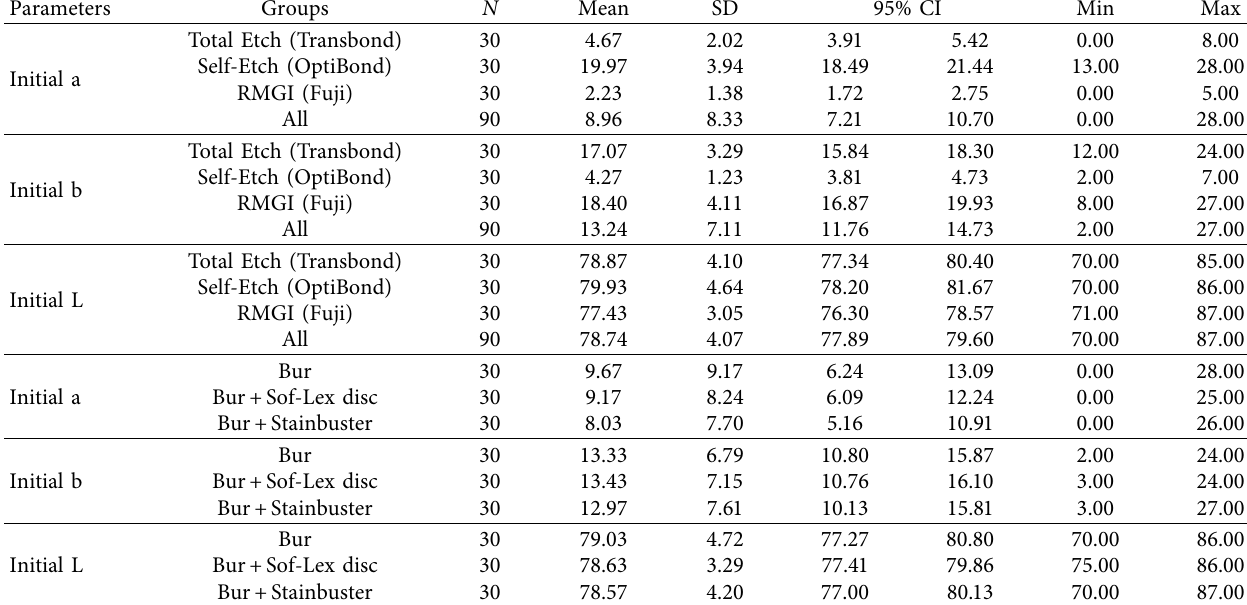
Table 1: Descriptive statistics and 95% CIs for the assessed parameters in each composite group ( n � 30), each resin removal group ( n � 30), and the whole sample ( n � 90).